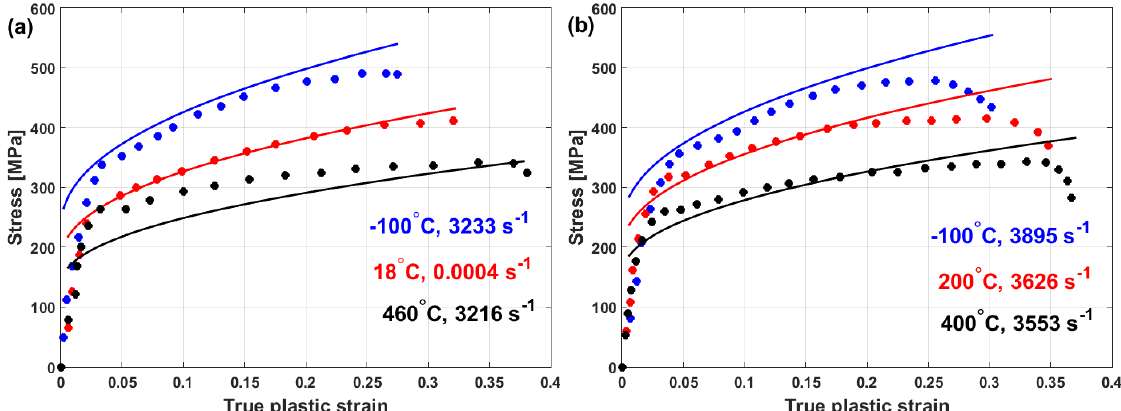
Figure 16. Experimental stresses (markers) compared to predicted stresses (solid lines) obtained by the modified JC that was presented by Hou Q. Y. et al. [74] for Mg–10Gd–2Y–0.5Zr alloy with the following dimensions: ( a ) Φ 10 mm × 5 mm and ( b ) Φ 10 mm × 4 mm.